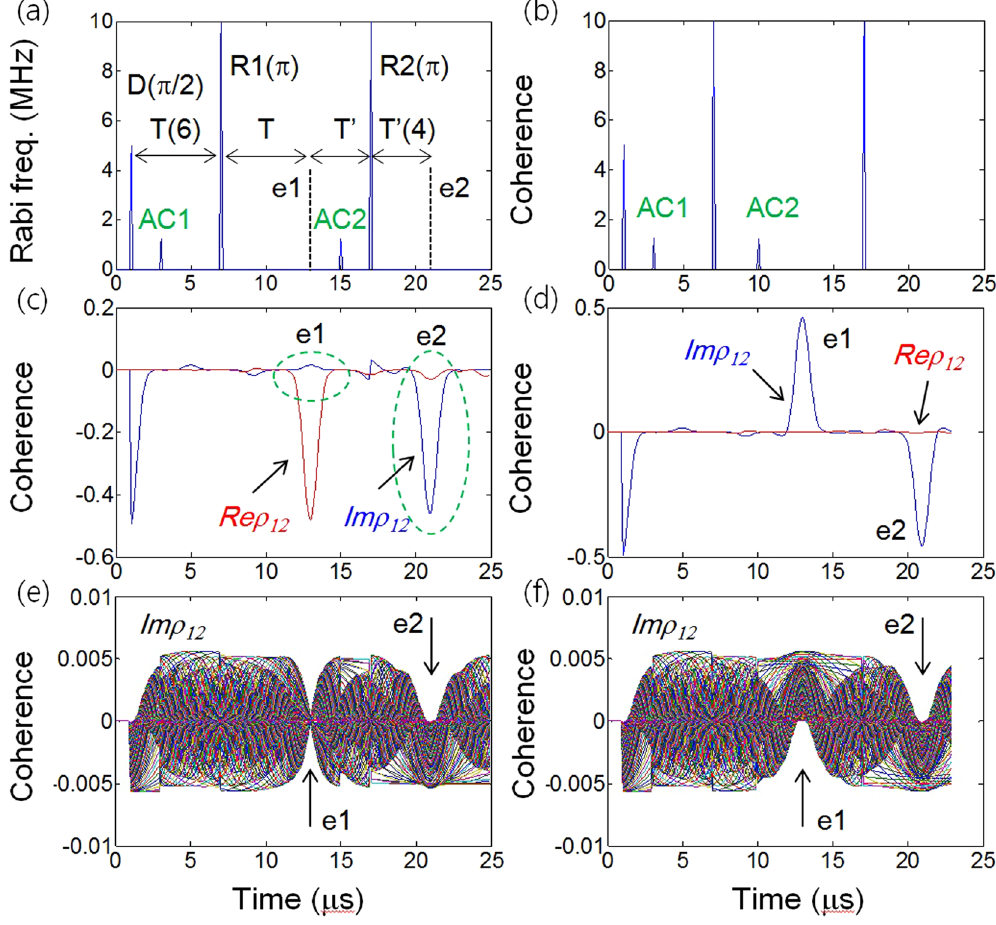
Figure 3. ac Stark control in doubly rephased photon echoes. ( a ),( b ) Pulse sequence: Data (D), Rephasing (R1), Rephasing (R2), ac Stark pulses (AC1) and (AC2). The numbers T and T’ represent the time durations in μ s, and the e1 (e2) timing is 13 (21) μ s. ( c – f ) Numerical calculations for optical coherence based on the time-dependent density matrix equations. ( c ) and ( e ) are the results for ( a ), whereas ( d ) and ( f ) are for ( b ). The time of arrival of D, AC1, R1, and R2 are 1, 3, 7 and 17 μ s, respectively. The arrival time of AC2 is ( a ) 15 μ s and ( b ) 10 μ s. The other parameters are the same as in Fig. 1, unless otherwise